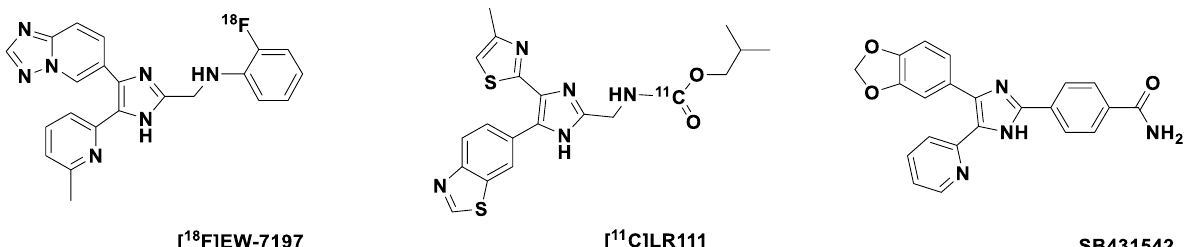
Fig. 1 Molecular structures of the ALK5 targeting PET tracers, [ 18 F]EW-7197 and [ 11 C]LR111, and the selective ALK5 kinase inhibitor